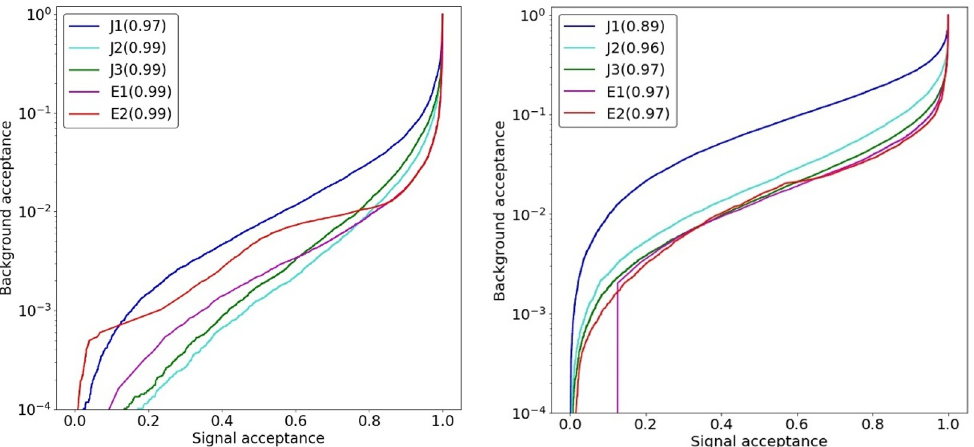
Figure 16 . ROC curves and their AUC for the binary classi(cid:12)ers to distinguish the Z (cid:23) h W and Z (cid:23) h W (right), from their respective background qq